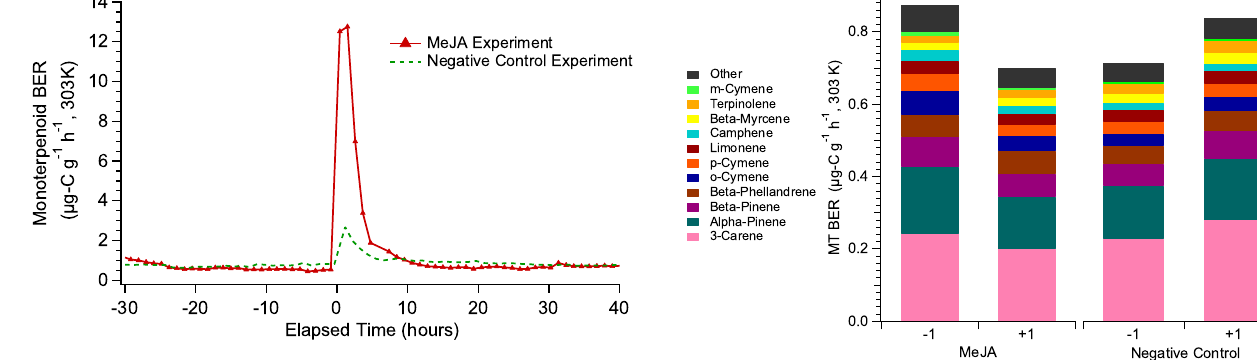
Figure 12. The Pinus aristata BVOC profile the day before treat- ment and the day after treatment for both the methyl jasmonate (MeJA) experiment (PA-E) and the negative control experiment (PA-C). The x axis denotes the day relative to treatment application. The y axis shows the monoterpenoid basal emission rate normal- ized to 303K. The left two bars illustrate the BVOC profiles from the methyl jasmonate (MeJA) experiment and the right two bars il- lustrate the BVOC profiles from the negative control